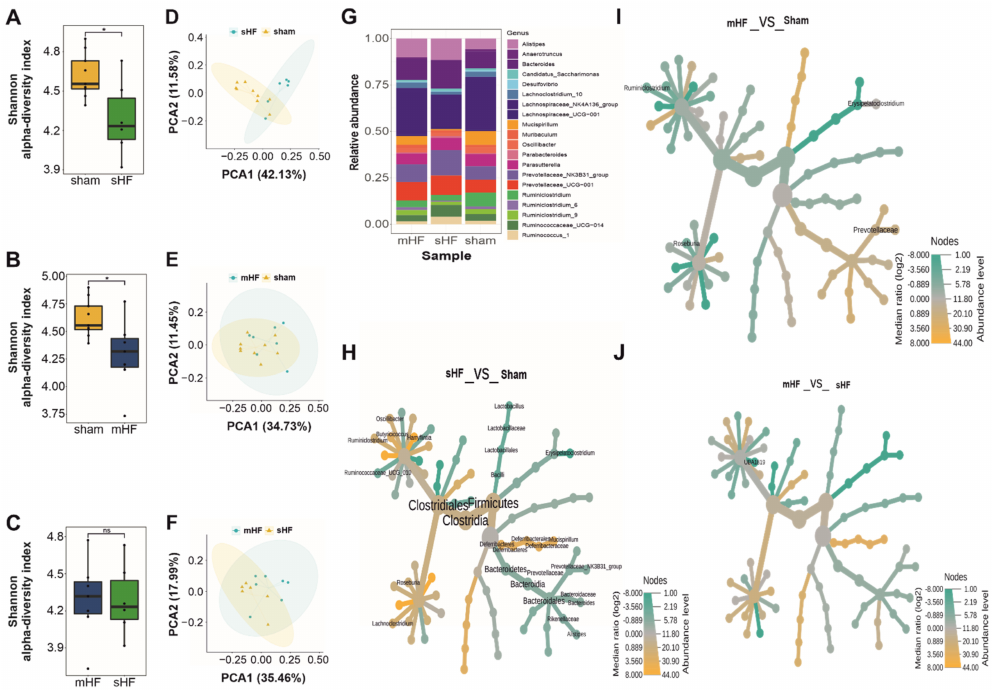
Figure 3. Diversity and microbial compositional differences in the mHF, sHF, and Sham samples. ( A ) Box plot for Shannon diversity index showing a significant difference in sHF vs. Sham samples ( p -value = 0.038). ( B ) Box plot for the Shannon alpha-diversity index showing significant differences in the mHF and Sham samples ( p -value = 0.039). ( C ) Box plot for the Shannon alpha-diversity index for the mHF and sHF samples showing no significant differences in samples. ( D ) PCoA plot with separate clustering in the sHF and Sham samples (PERMANOVA p -value: 0.258, beta dispersion p -value: 0.2498). ( E ) PCoA analysis of the mHF and Sham samples with no distinct cluster formation (PERMANOVA p -value: 0.411, beta dispersion p -value: 0.3976). ( F ) PCoA analysis results of the sHF and mHF samples showing no significant differences (PERMANOVA p -value: 0.733, beta